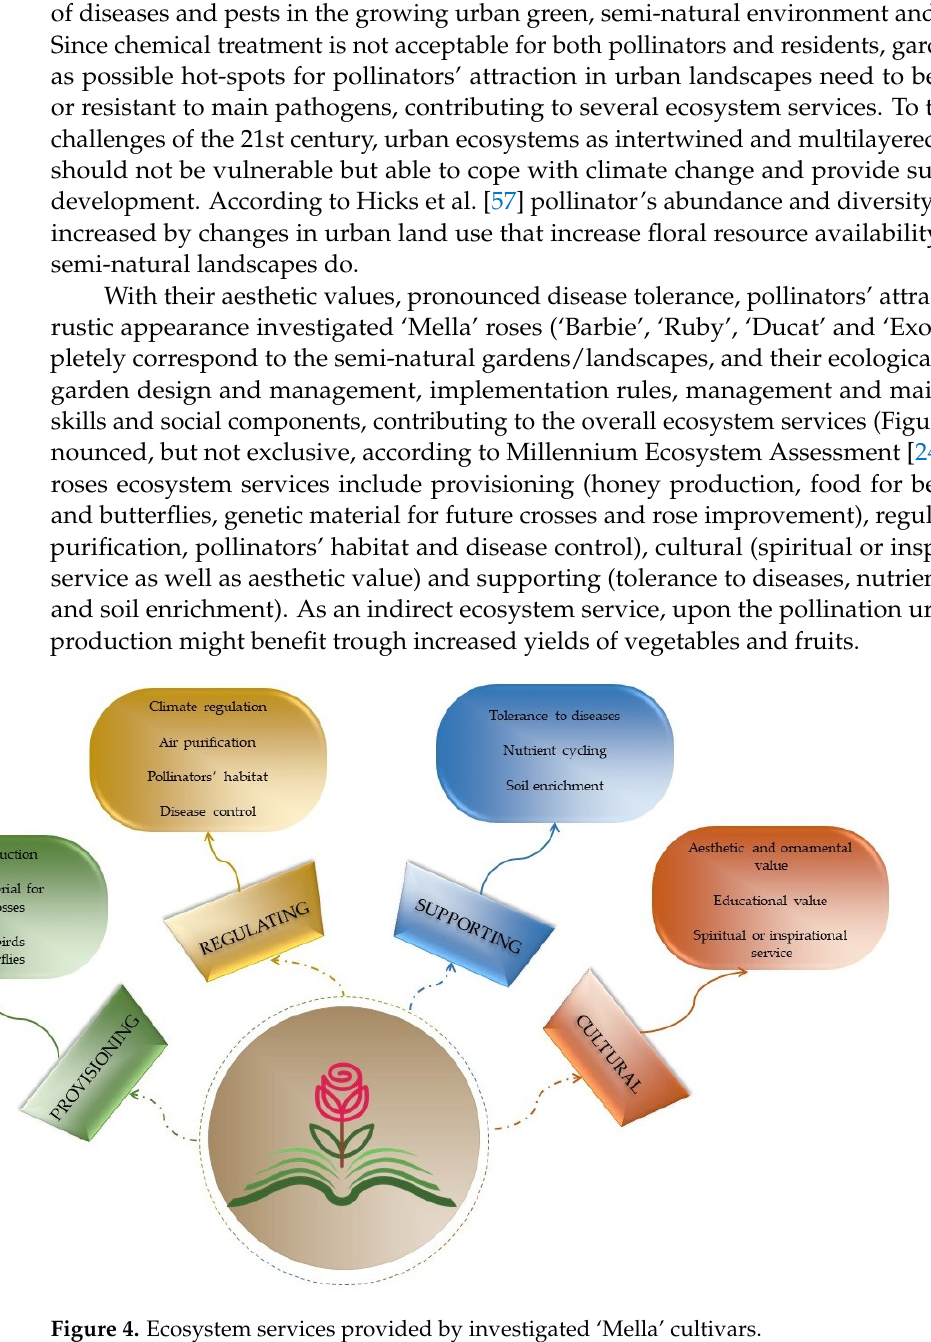
Figure 4. Ecosystem services provided by investigated ‘Mella’